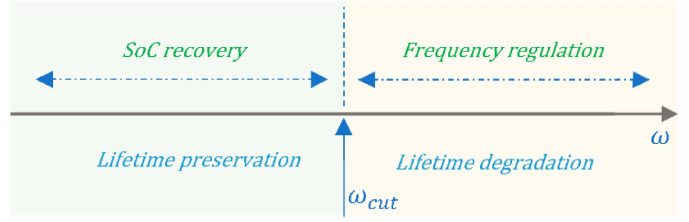
Figure 8. Cut-off frequency choice